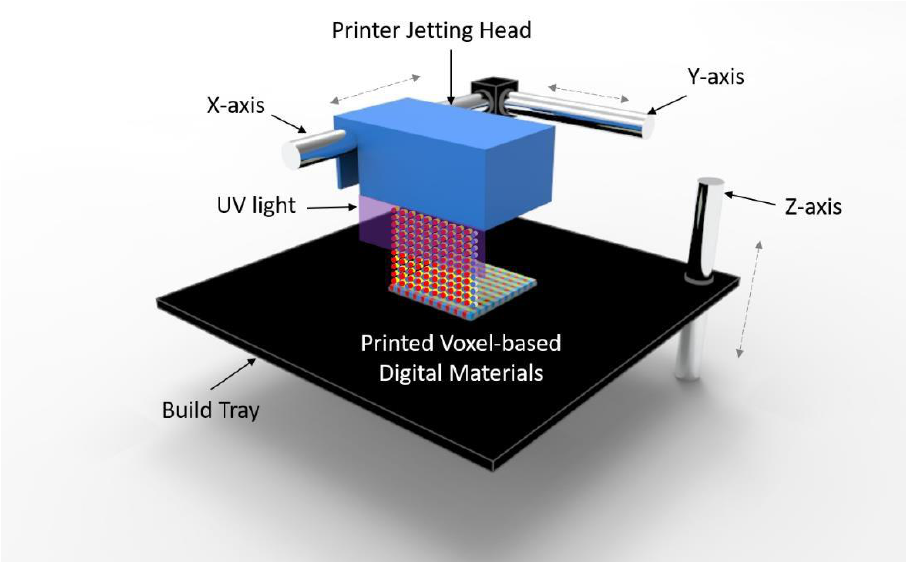
Figure 1. Illustration of Polyjet 3D printing. The printer jetting head moves along the x- and y-axis while printing a digital material on the build tray. The build tray moves up and down along the z-axis during printing. The printed each layer is cured by the UV ramps mounted on the printer head.